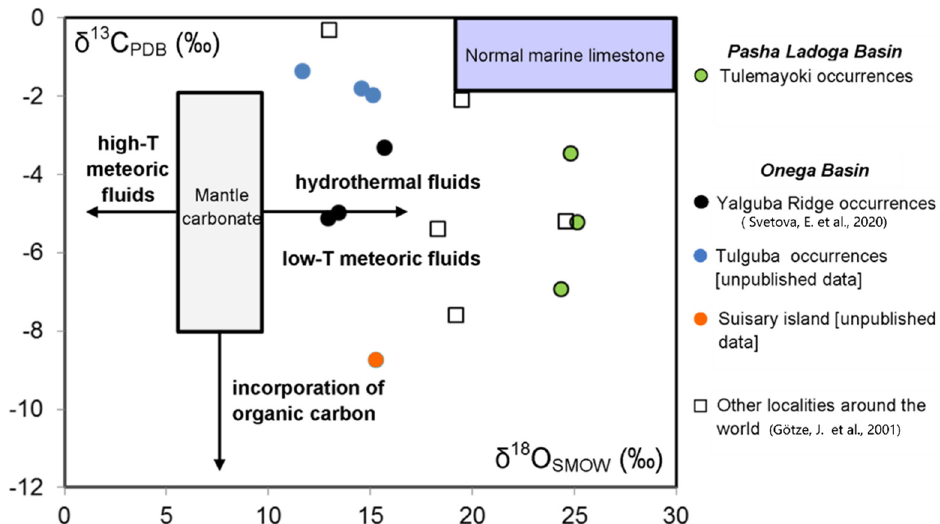
Figure 14. Plot of the oxygen-versus-carbon isotope results for agate-associated calcite samples from the Salmi occurrence (Pasha–Ladoga Basin) along with data available for agates of the Paleoproterozoic Onega Basin (NW Russia) and other localities around the world [3,7]. Mantle carbonate box and trends showing how various processes would affect the C-O isotope composition of magmatic carbonates are given according to Giuliani et al. [36], normal marine limestone [37].